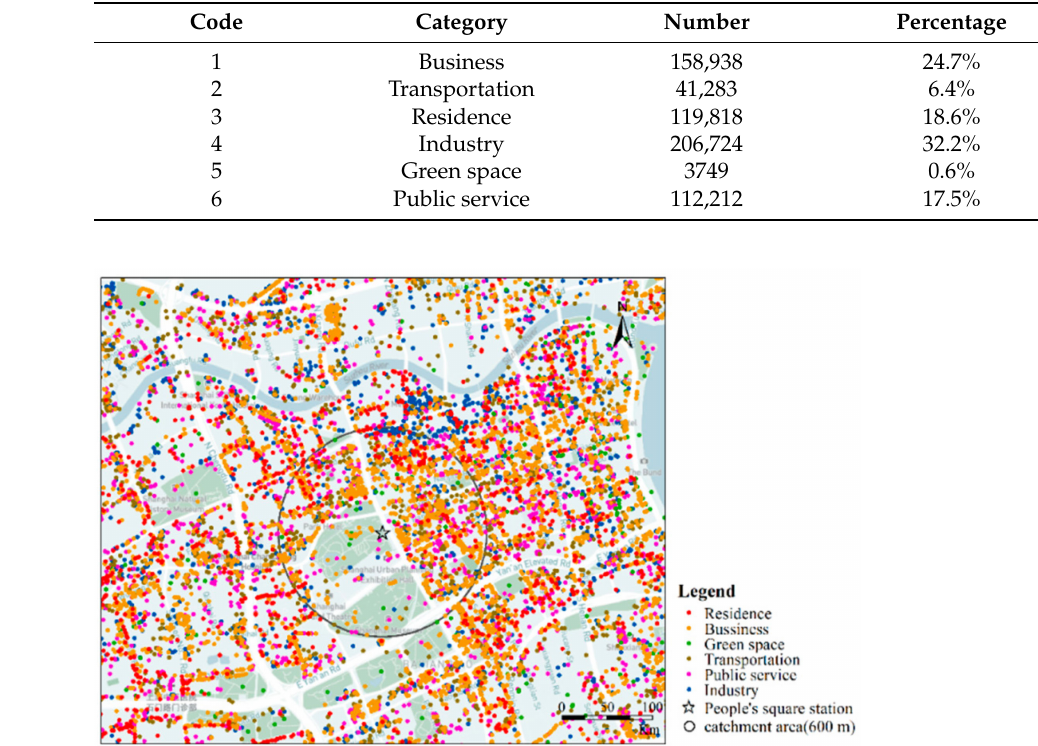
Figure A1. POI distribution around People’s Square.